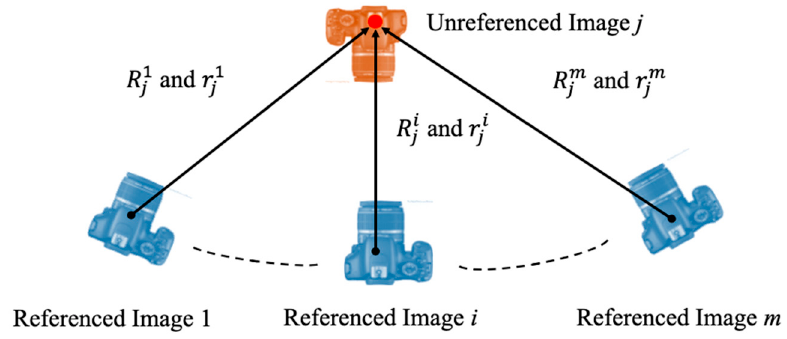
Figure 6. The tree structure for referenced (blue color) and unreferenced (red color) images. Rotational Parameters Estimation: